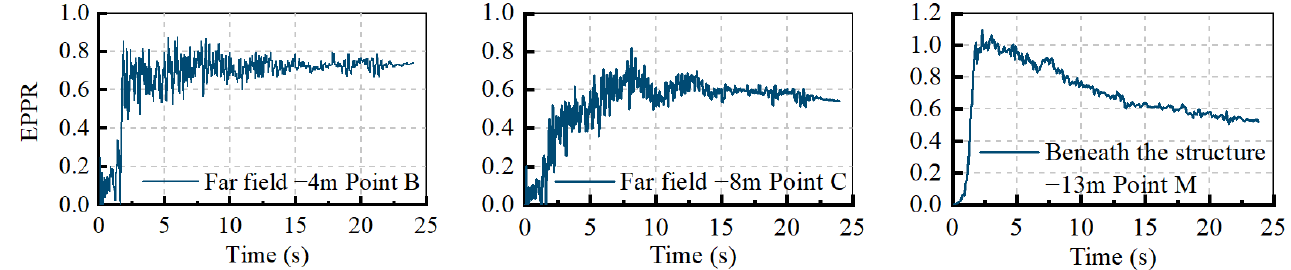
Figure 8. Time histories of pore water pressure ratios of soils at different locations in the 2 m burial depth model.